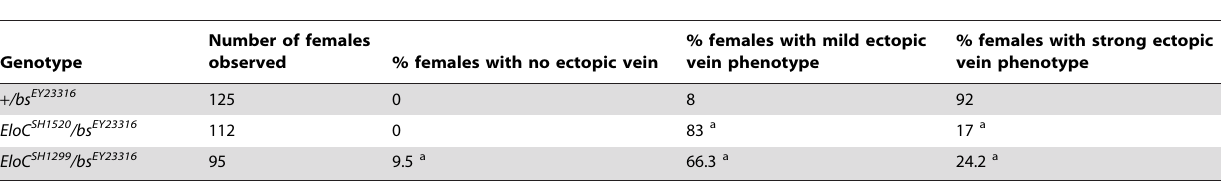
Table 2. Decreasing EloC expression suppresses ectopic veins induced by blistered loss-of-function.